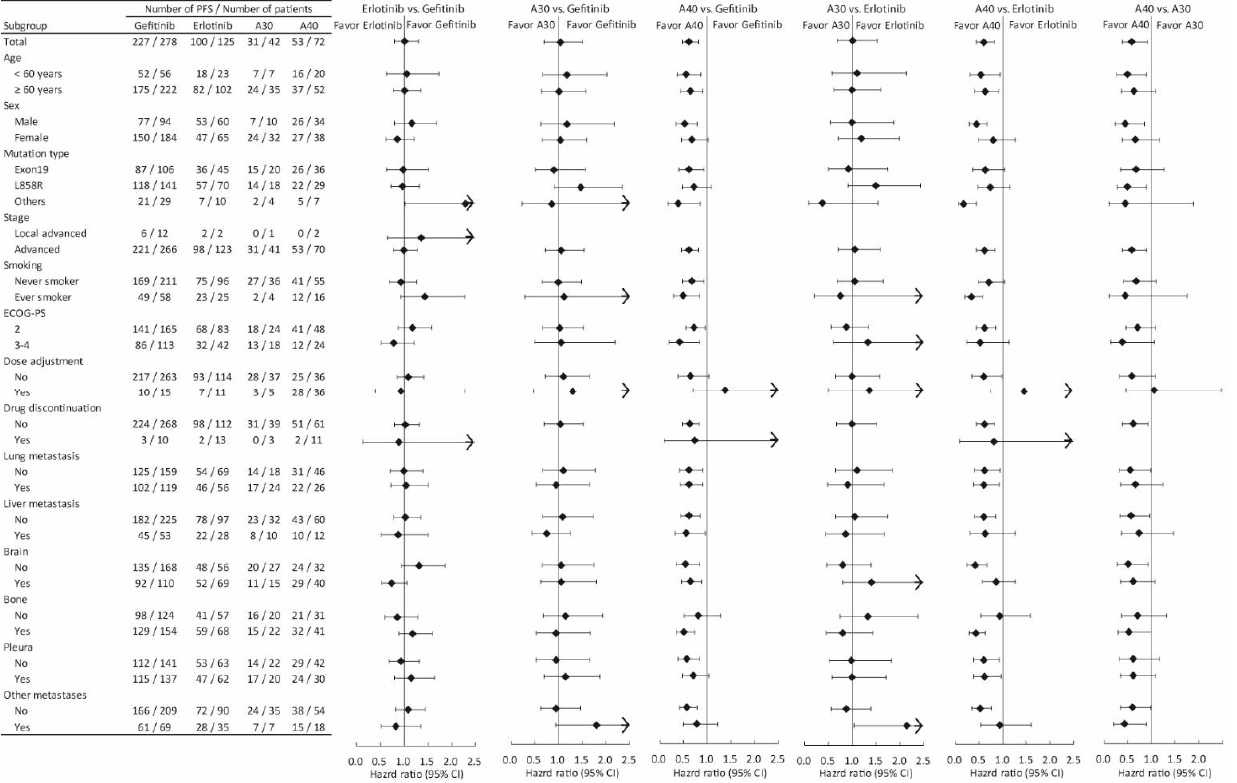
Figure 4 . Subgroup analysis comparing progression-free survival among the different epidermal growth factor receptor tyrosine kinase inhibitors treatments, stratified by selected baseline characteristics.